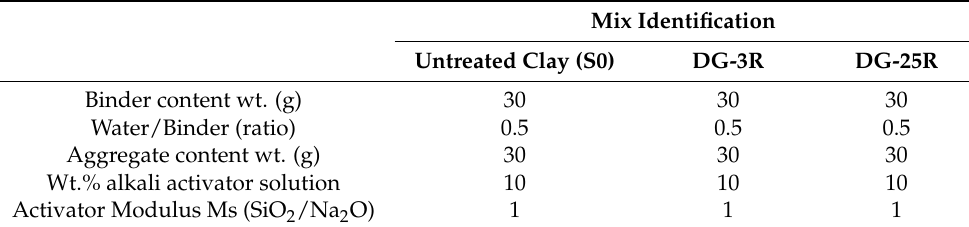
Table 3. Mix composition of Alkali-Activated raw